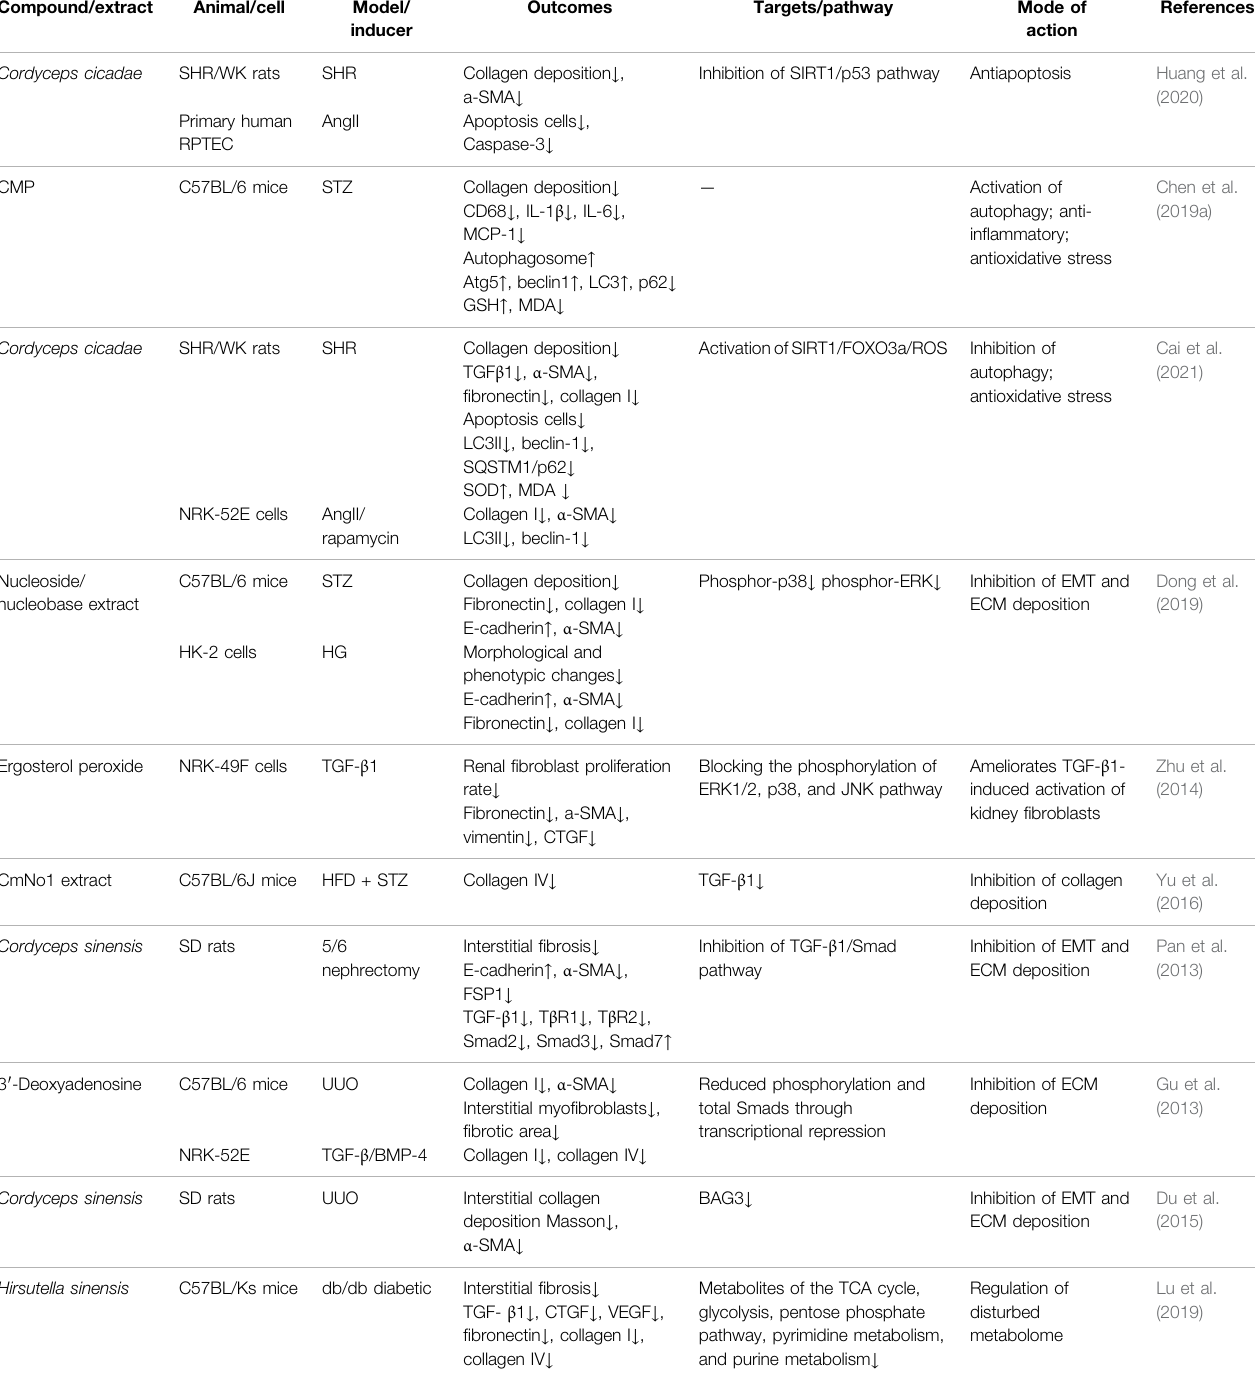
TABLE 1 | ( Continued ) Mechanisms of Cordyceps and related products against renal fi